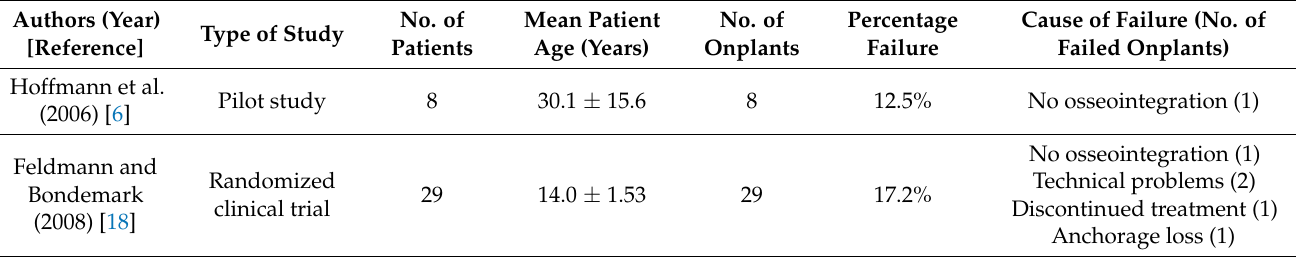
Table 2. Failure rates of Onplant studies in